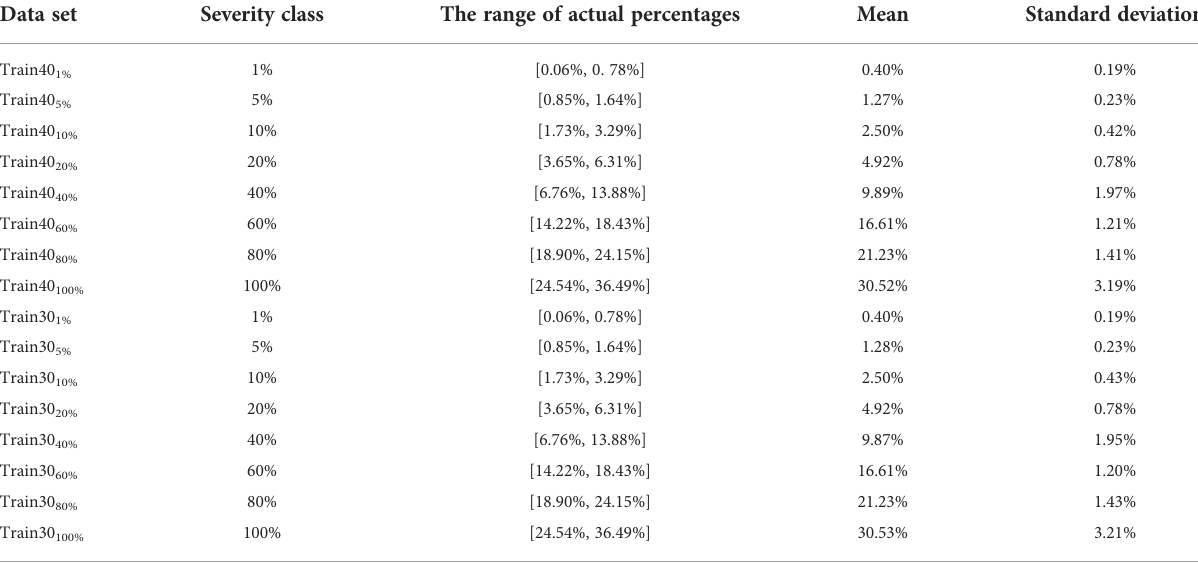
TABLE 2 Statistics of the actual percentage data of the lesion areas in the areas of the corresponding whole diseased leaves contained in each training set (Train40 R or Train30 R ) of the severity class of R including the range of actual percentages of lesion areas, mean, and standard